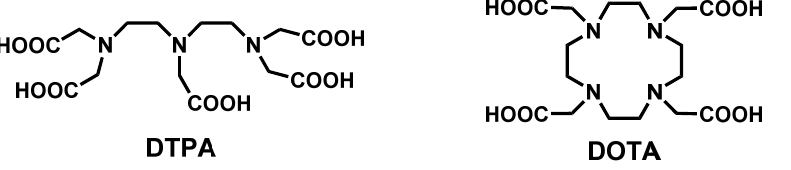
Figure 1. The two standard ligand scaffolds used in clinically approved GBCAs. (DTPA = diethylenetriaminepentaacetic acid or pentetic acid; DOTA = 1,4,7,10-tetraazacyclododecane-1,4,7,10-tetraacetic acid or tetraxetan).